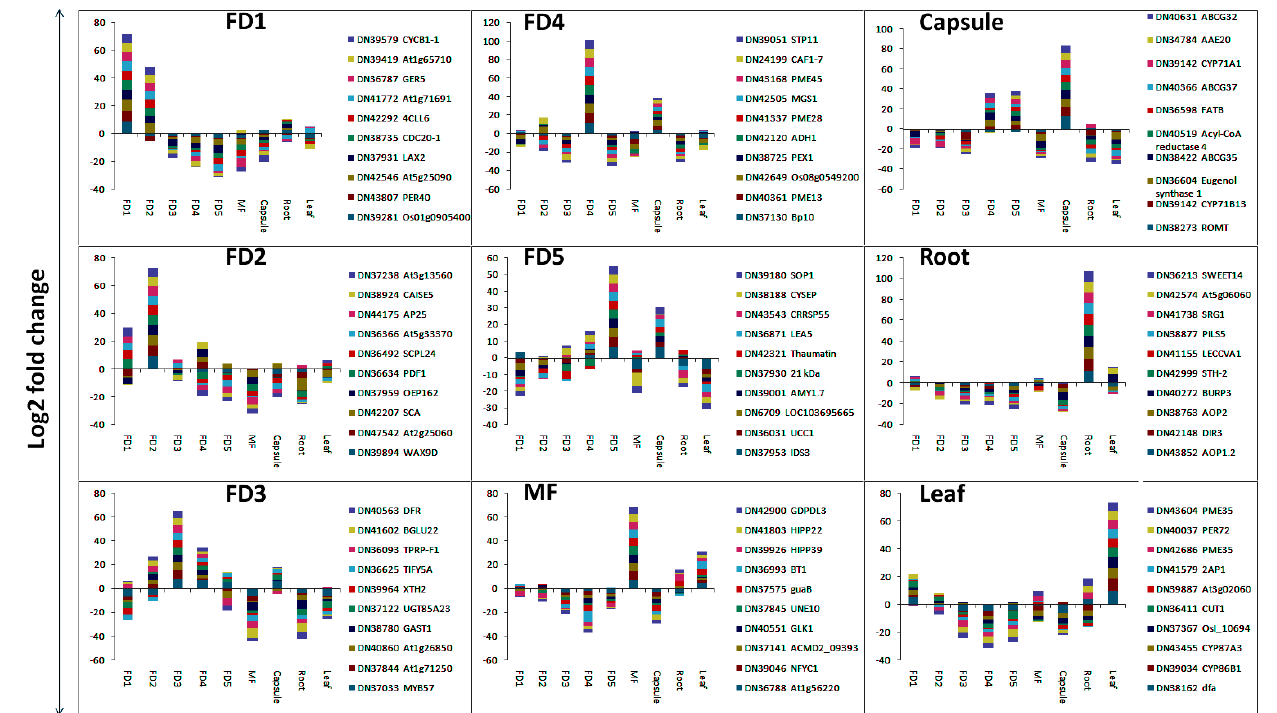
Figure 4. Top 10 highly expressed DEGsin each stage of flower development and tissue type.